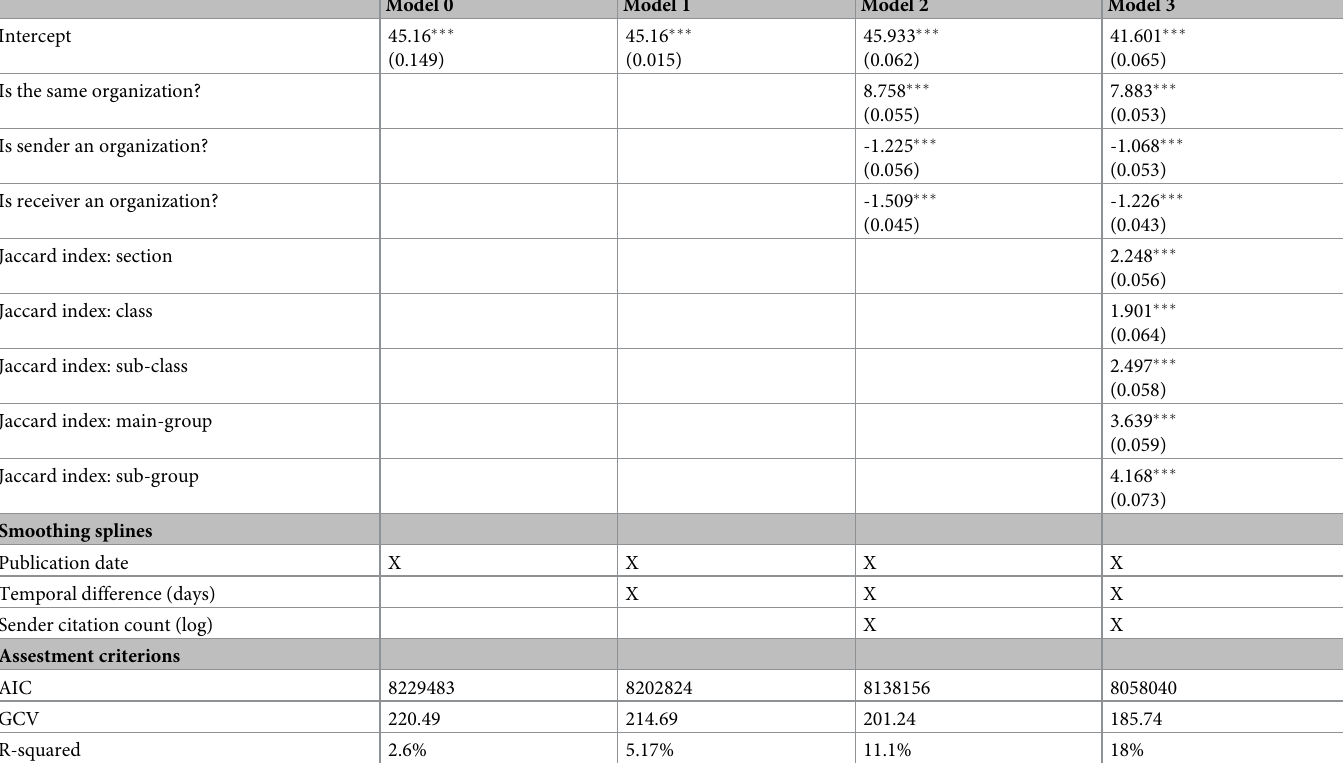
Table 2. Coefficient estimates for the fixed parametric effects in the three model specifications. Refer to Fig 4 for the smoothing splines terms. Asterisk symbol repre- sents the levels of statistical significance, while values in parenthesis are the related standard errors. Model assessment criteria can be found at the bottom of the table. For our purposes, we compared three different criteria: Akaike Information Criterion (AIC), Generalized Cross Validation (GCV) criterion and the Deviance explained (R-